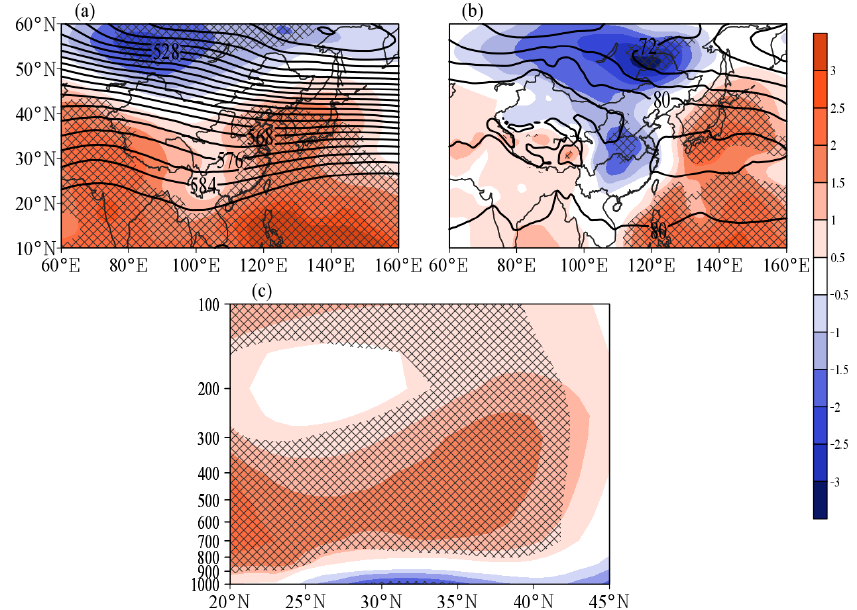
Figure 5. ( a ) The composite of original 500 hPa geopotential height (GH) (contours, unit: gpm) and standard anomalies of GH (shaded) from 24 November to 3 December in 2018. ( b ) is the same as in ( a ) but for 925 hPa GH. ( c ) The vertical section of composite standard anomalies of GH across 120° E. The crossed area in each panel denotes anomalies exceeding the 0.01 significance level.